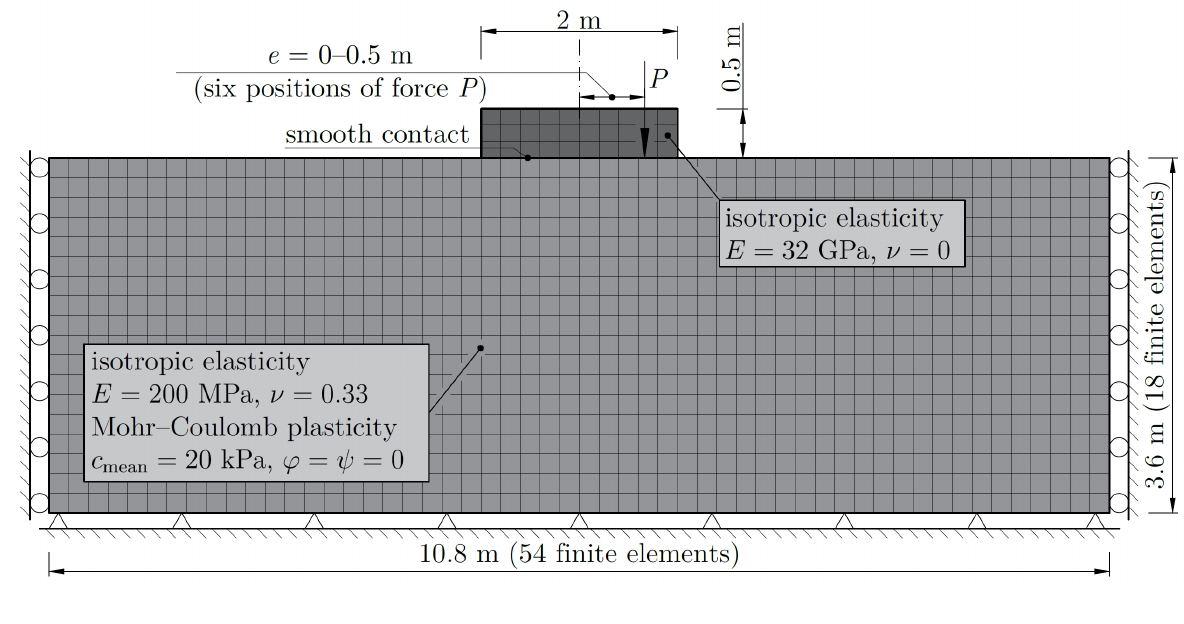
Figure 1: FE model scheme.